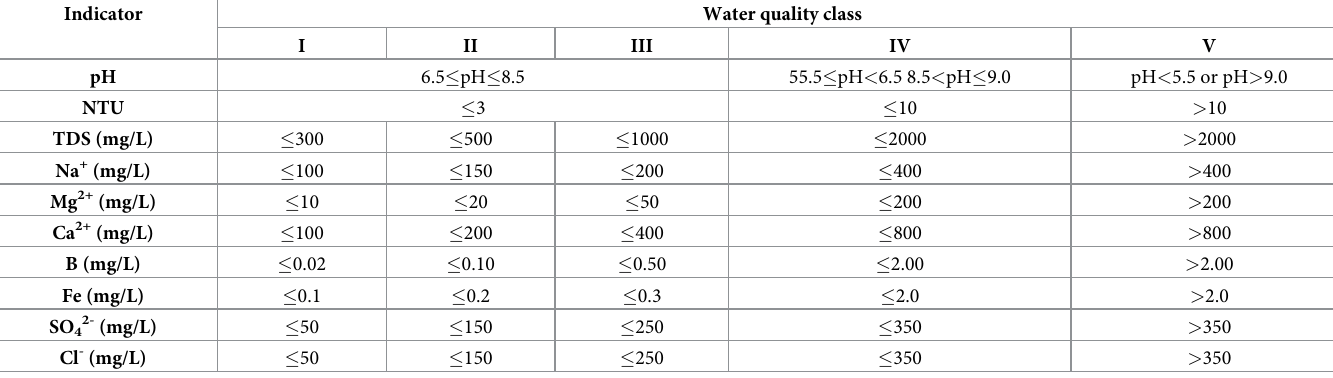
Table 4. Standards for groundwater quality based on 10